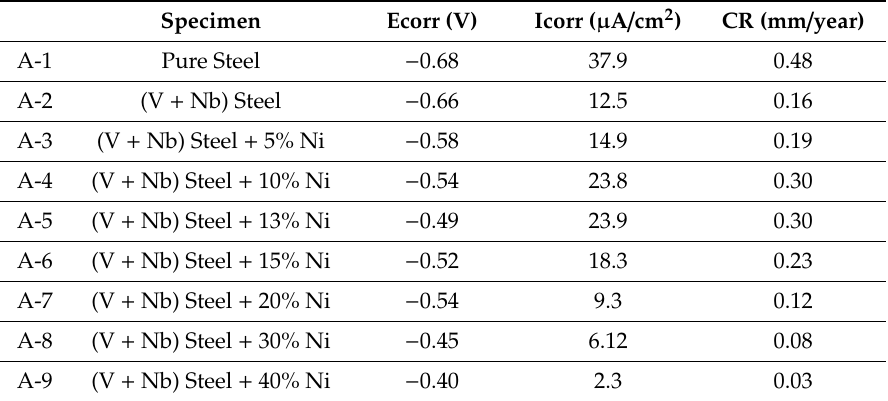
Table 3. Ecorr and Icorr values of the alloys.